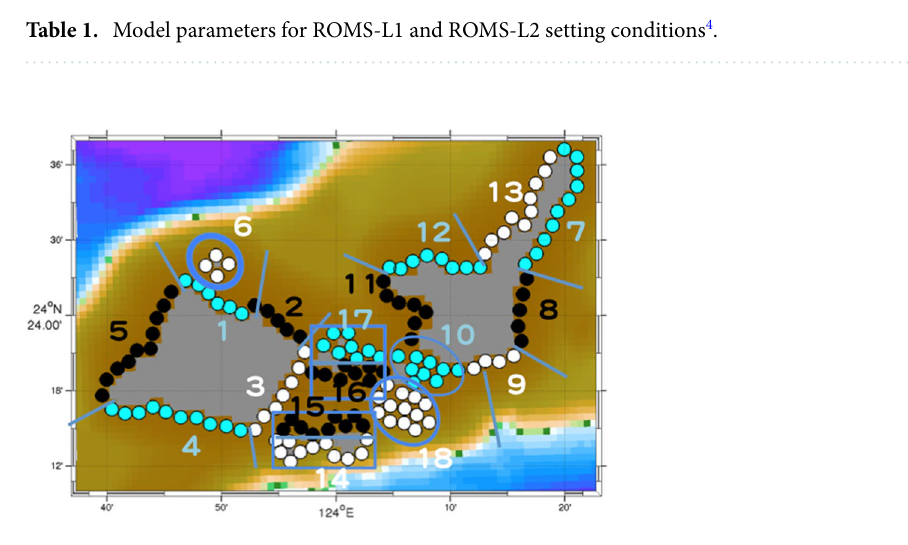
Figure 2. Close-up of the model domain around Sekisei Lagoon. Circles indicate source and destination areas separated into numbered groups. Groups 3, 10, and 14–18 are located in the interior and the remainder are outside of the